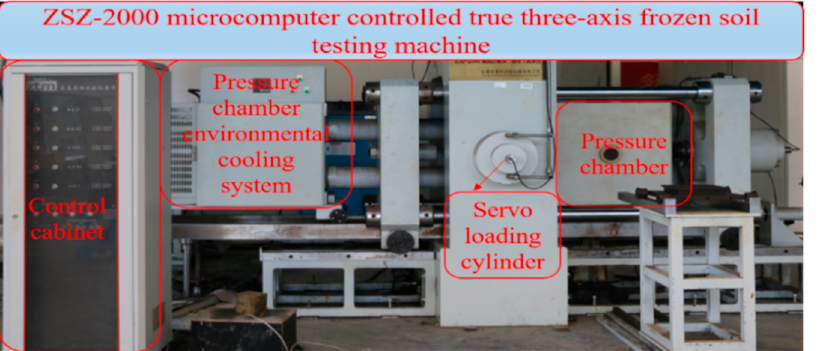
Figure 2. True triaxial test platform for frozen soil.